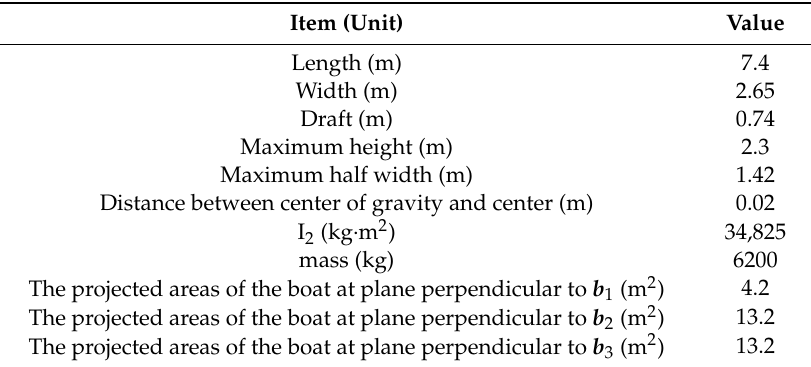
Table 1. Basic information of the boat.